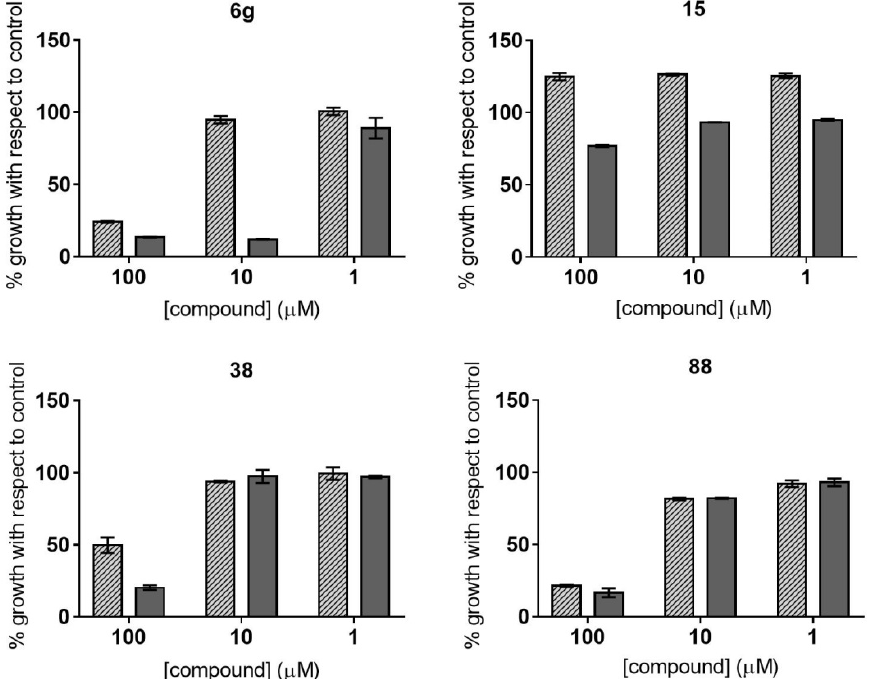
Figure 2. Parasite growth at three concentrations of representative compounds from different structural groups. Filled bars represent P. falciparum growth, whereas dark grey bars represent T. cruzi growth.